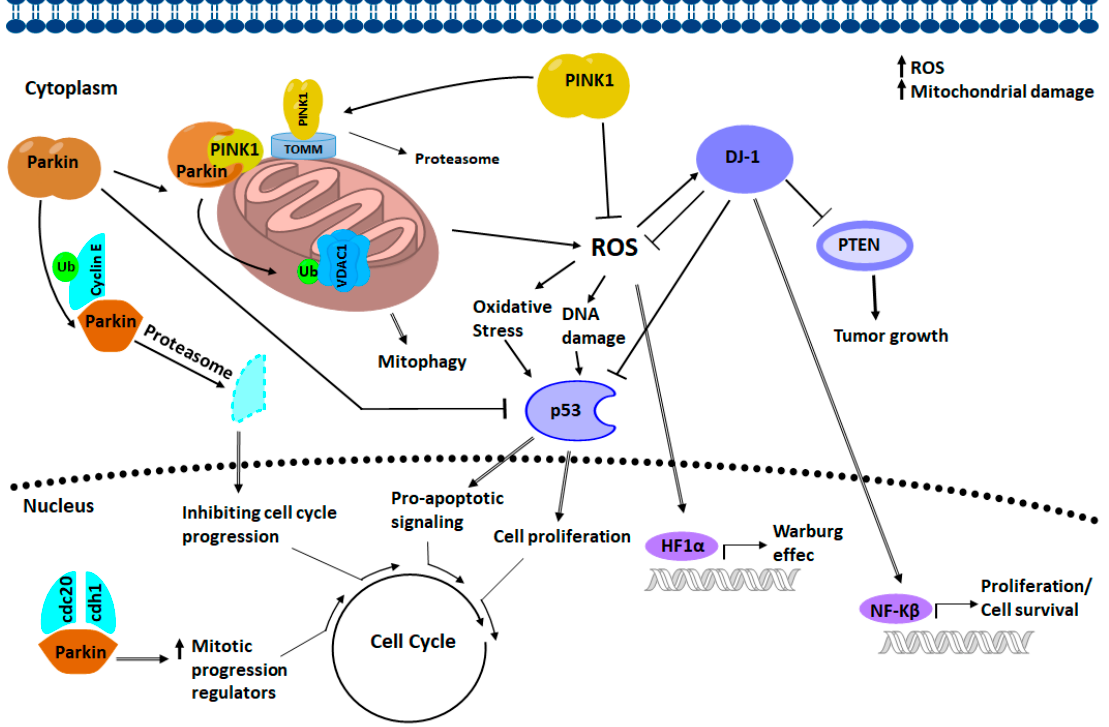
Figure 9. Representation of PARKIN/PINK1/DJ-1 network. The directionality and the nature of the interactions (activation or inhibition) are shown as they are believed to exist in a healthy state. PARKIN interacts with PINK1 to promote the removal of defective mitochondria through the ubiquitination of the voltage-dependent anionic channel 1 (VDAC1), a component of the mitochondrial permeability transition pore that is involved in apoptosis, contributing to limit the damage produced by ROS. The STRING database and Gene Ontology (GO) enrichment analysis were performed to consolidate known and predicted protein-protein association with PINK1, PARKIN, and DJ-1. The enrichment analysis of KEGG pathways showed that the PINK1/PARKIN/DJ-1 network show Parkinson disease as the main feature. Only the protein DJ-1 showed enrichment in prostate cancer and p53 signaling pathway. Some predicted transcription factors regulating PINK1 , PARK2 (PARKIN) and PARK7 (DJ-1) gene expression are related to cell cycle control. We suggest that the interplay among PINK1/PARKIN/DJ-1 network during mitochondrial quality control in cancer biology may occur at the transcriptional level. Further analysis, like a systems biology approach, will be helpful in the understanding of PINK1/PARKIN/DJ-1